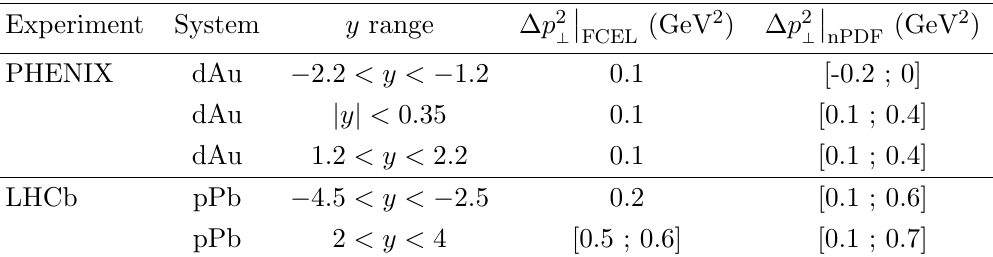
(cid:12) and (cid:1) p 2 (cid:12) FCEL ?